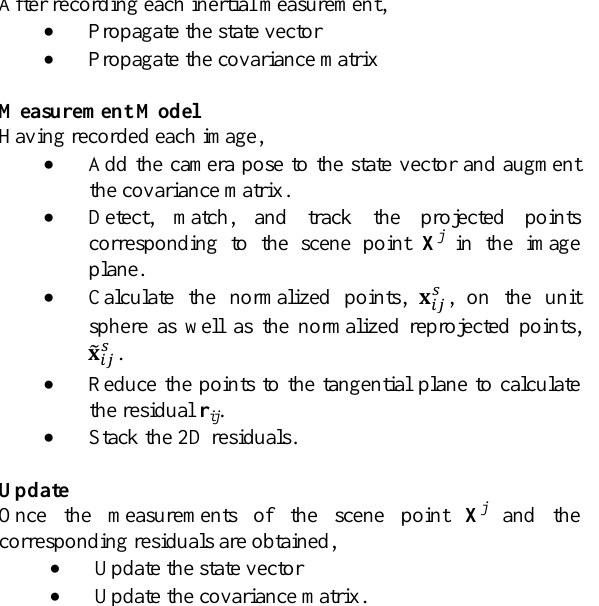
Algorithm 1 The proposed OVIO based on the MSCKF System model